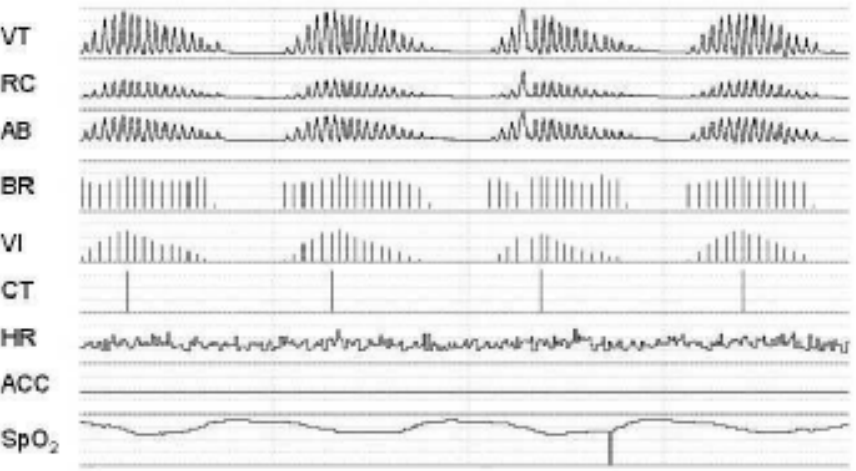
Pathophysiology of Cheyne-Stokes respiration Left heart failure causing increased pulmonary venous pressure is regarded as the source of CSR. Elevated pulmonary venous pressure leads to pulmonary congestion which stimulates the pulmonary stretch receptors, and they in turn heighten sensitivity to CO 2 through their vagal af- ferents [12–14]. Since CO 2 sensitivity increases, patients begin to hyperventilate and arterial CO 2 (PaCO 2 ) falls until it crosses the apnoea threshold [15]. If chemical control prevails over cortical in- fluence on the respiratory controller, such as typ- ically occurs during sleep, patients become apnoeic until the PaCO 2 rises again above the apnoea threshold and the alternating pattern of apnoea and hyperpnoea continues because of the ongoing oscillations of PaCO 2 around the apnoea thresh- old [16, 17]. This periodic respiratory over- and undershoot causes additional sympathetic